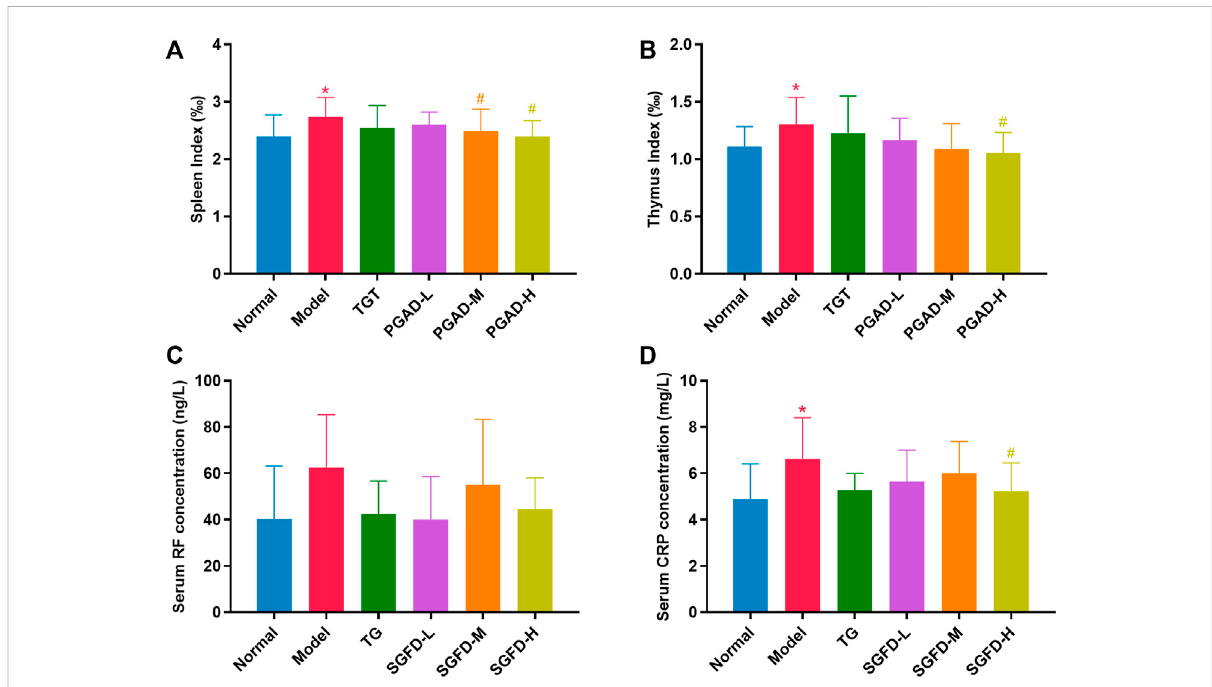
FIGURE 5 Effects of SGFD on the spleen and thymus index and the serum levels of RF and CRP. (A) . Spleen index. (B) . Thymus index. (C) . Serum RF concentration. (D) . Serum CRP concentration. Data were shown as mean ± SD (Normal, n = 13; Model, TG, SGFD-L, SGFD-M, n = 12; SGFD-H, n